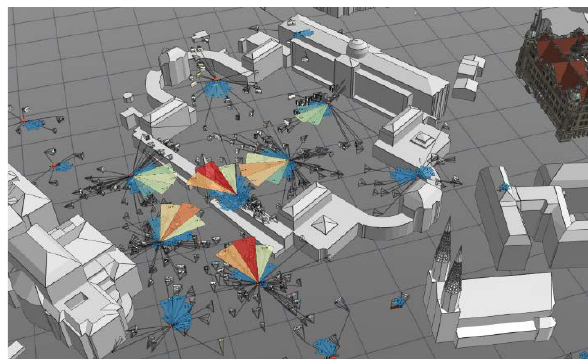
Figure 6. Radial fan, visualizing the most popular angles (red) of photographs